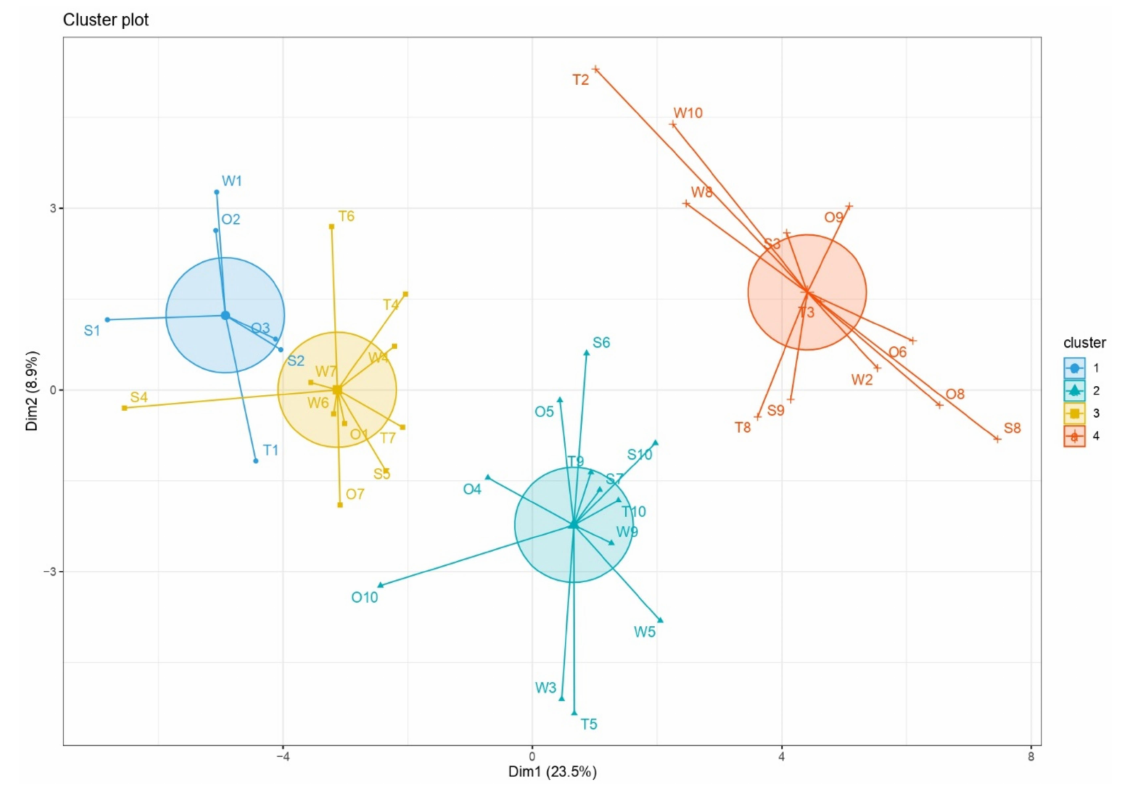
Figure 3. Clusters were determined by principal component analysis considering every surveyed group and 40 variables from the SWOT matrix.